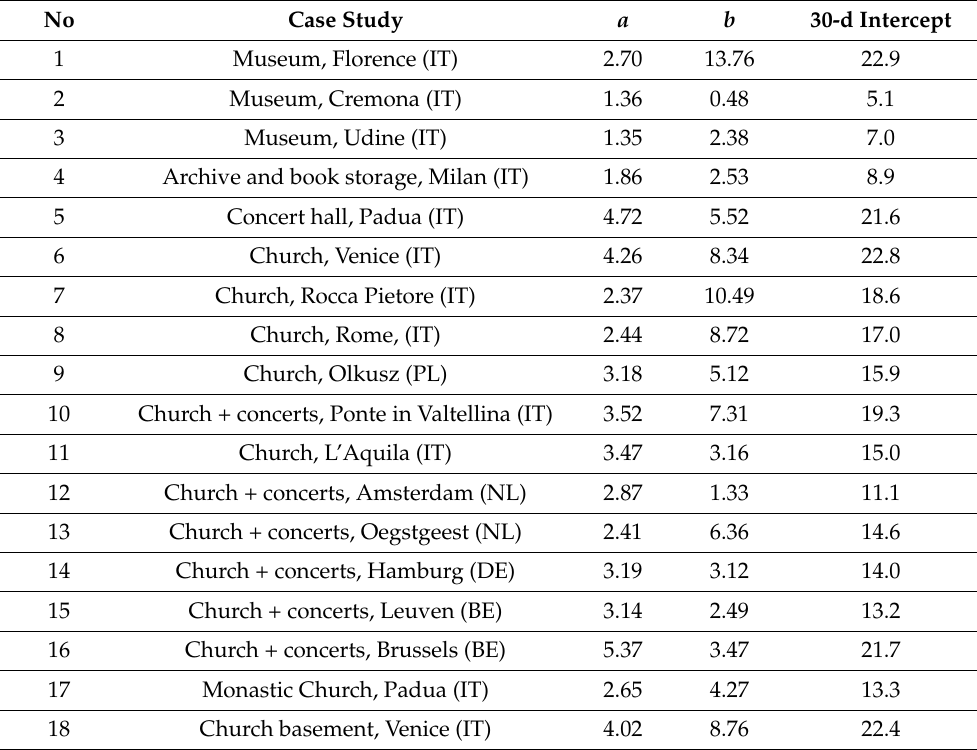
Table 3. Coefficients a , b of the logarithmic Equation (3) representing the dependence of the average safe band on the selected time window duration. The last column is the 30-day